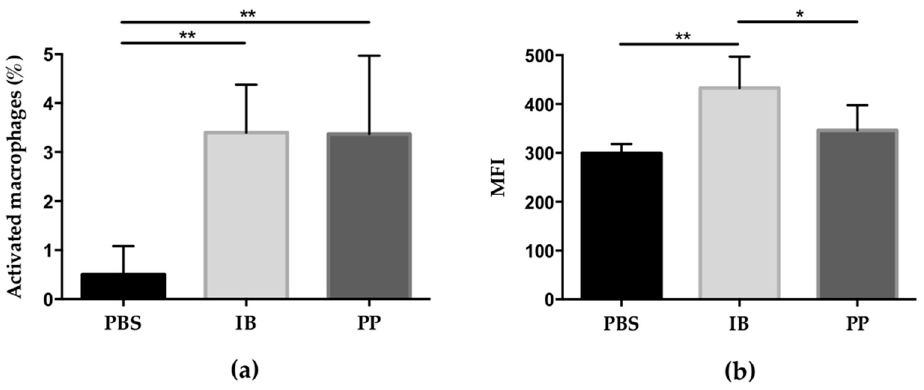
Figure 3. Evaluation of the activation of peritoneal macrophages and production of intracellular nitric oxide in CD1 mice infected with T. gondii RH: ( a ) the percentage of activated macrophages in the peritoneal cavity is increased in treatments with lactobacilli, regardless of whether they are alive or dead, compared to the control group; ( b ) there is an increase in the production of nitric oxide in the group treated with immunobiotic compared to the other two groups. Data were combined from two individual experiments with three to five mice per group. Values represent the means ± SD. * p < 0.05; ** p < 0.01. PBS) phosphate buffered saline; IB) immunobiotic; PP) paraprobiotic; MFI) mean fluorescence intensity.